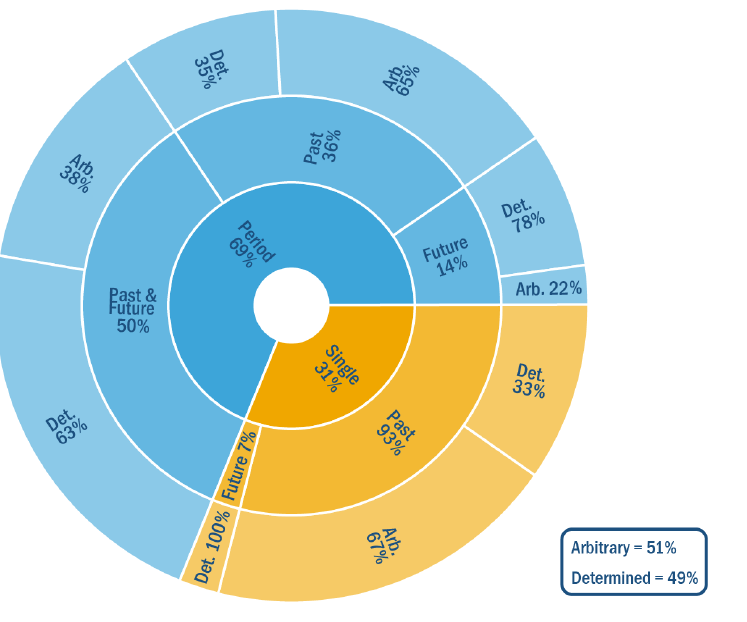
Figure 4. Summary of the temporal extension (period, single), position (past, future, past and future), and motivation (arbitrary, determined) of the selected 96 articles. The box in the figure indicates the percentage of arbitrary and determined studies in the total sample.